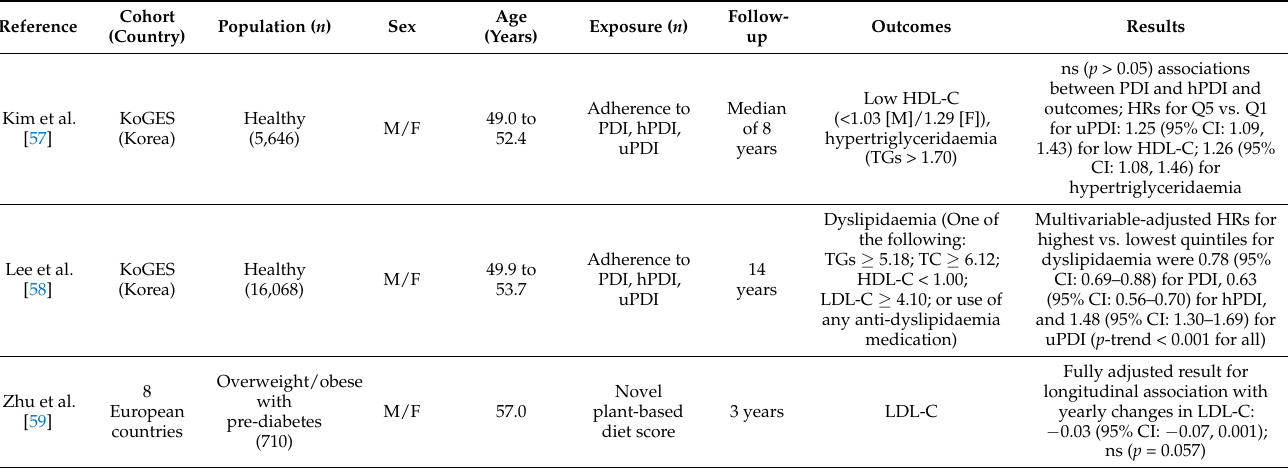
Table 7. Prospective Cohort Studies of Plant-Based Diet Indices and Lipid